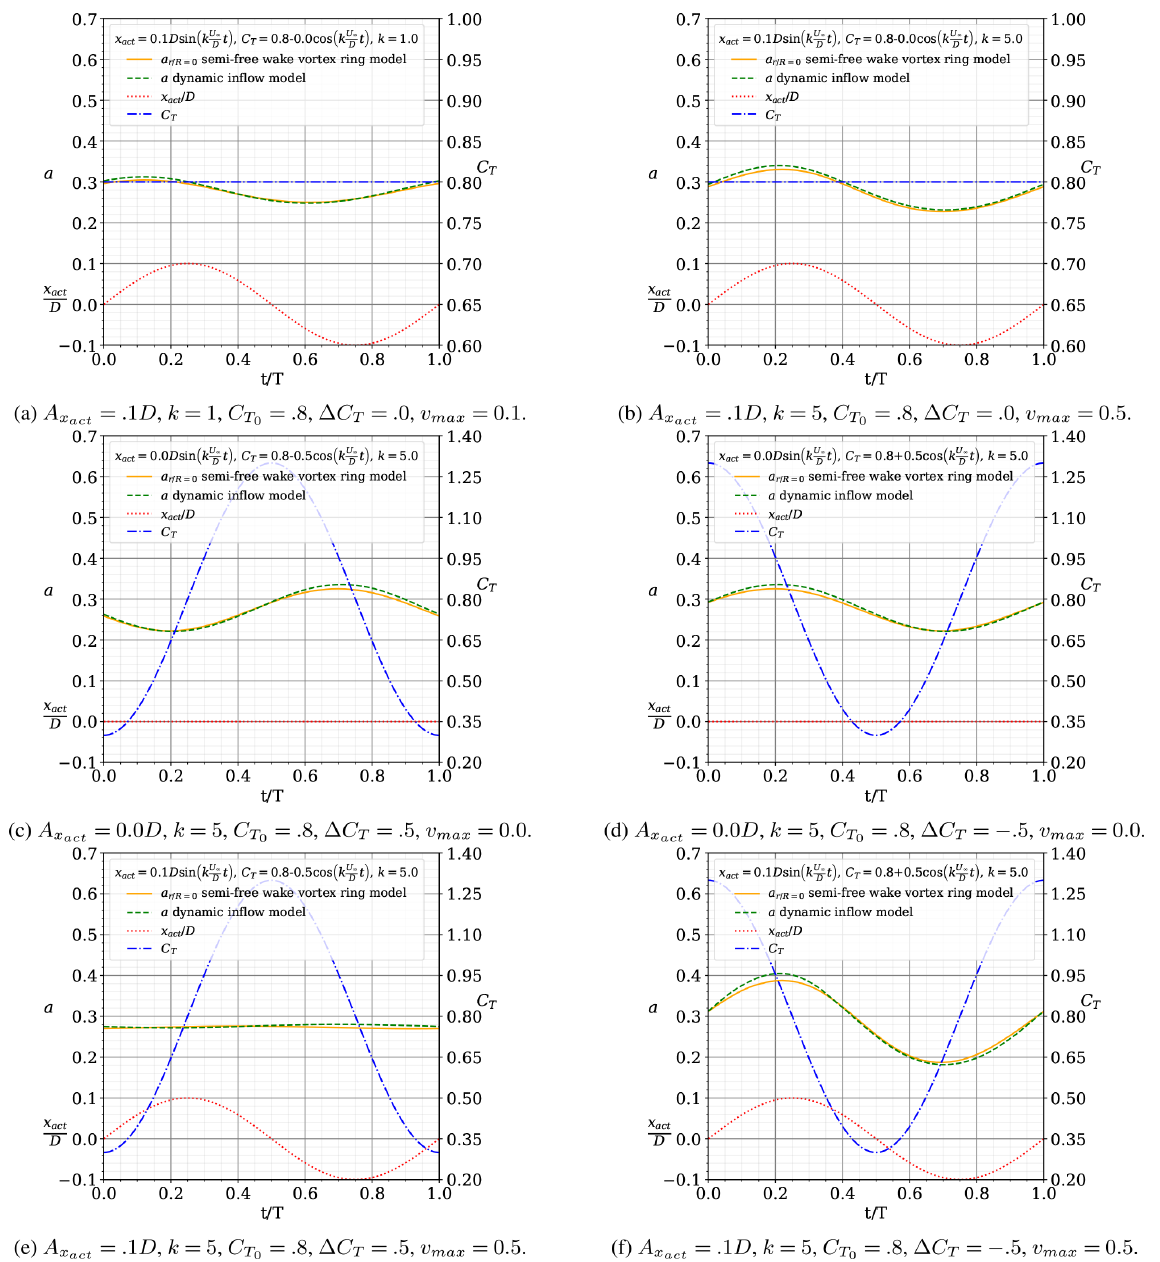
Figure 5. Comparison of the results of induction by the semi-free-wake vortex ring model and the proposed dynamic inflow model at the centre of the actuator r/R = 0 for a sinusoidal surge motion with x act = A x (cid:49)C T cos ( kU ∞ /Dt ) (also plotted). The results are plotted over one period, along the non-dimensional time t/T . The results detail the separate effects of motion and